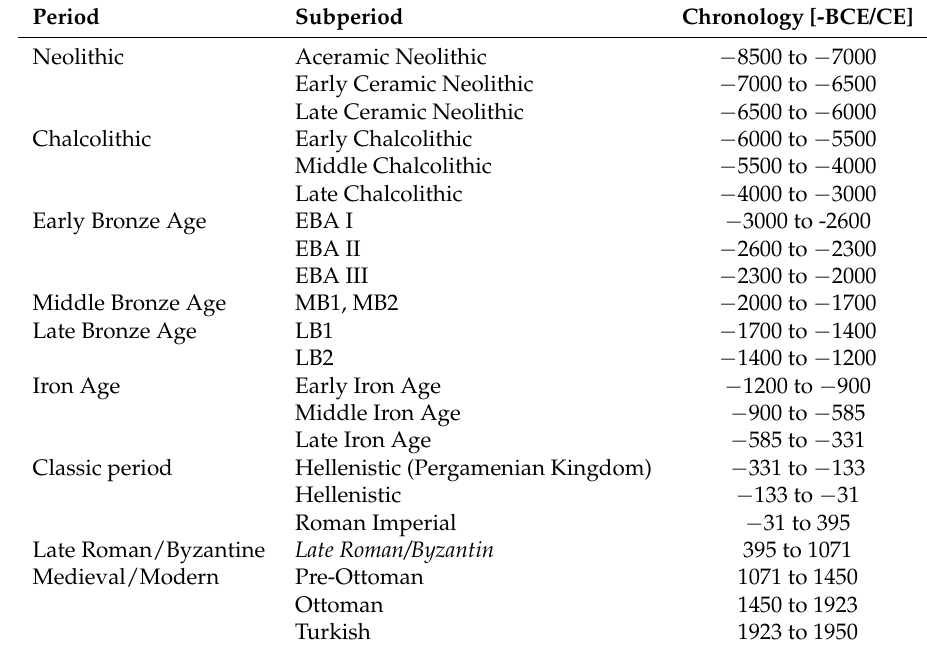
Table A1. Overview on the archaeological periods as used in this study. Periodisation is